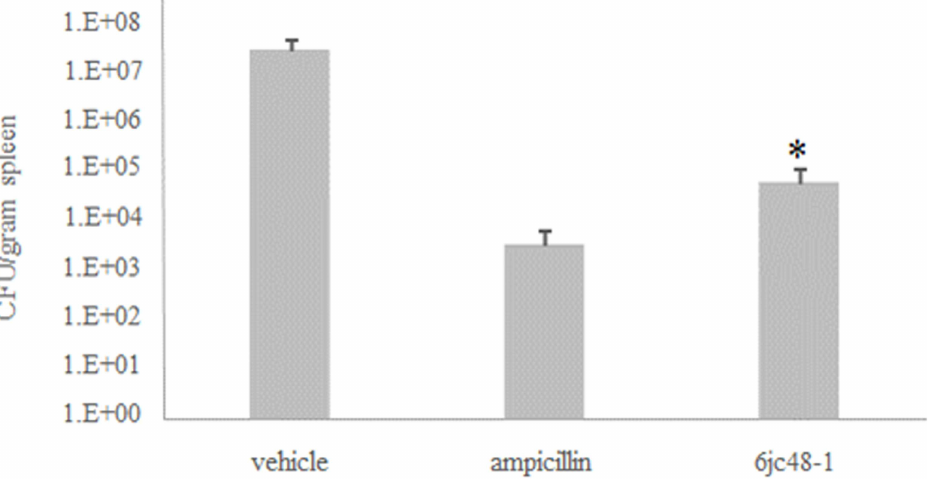
Fig 5. In vivo efficacy of 6jc48-1 in murine sepsis. Spleen samples were collected from vehicle-treated, ampicillin(300 mg/kg) treated or 6jc48-1(100 mg/kg) treated animals at 20 h post-infection with 5 x 10 8 CFU/ animal of E . faecalis EF1509. * One animal treated with compounddid not